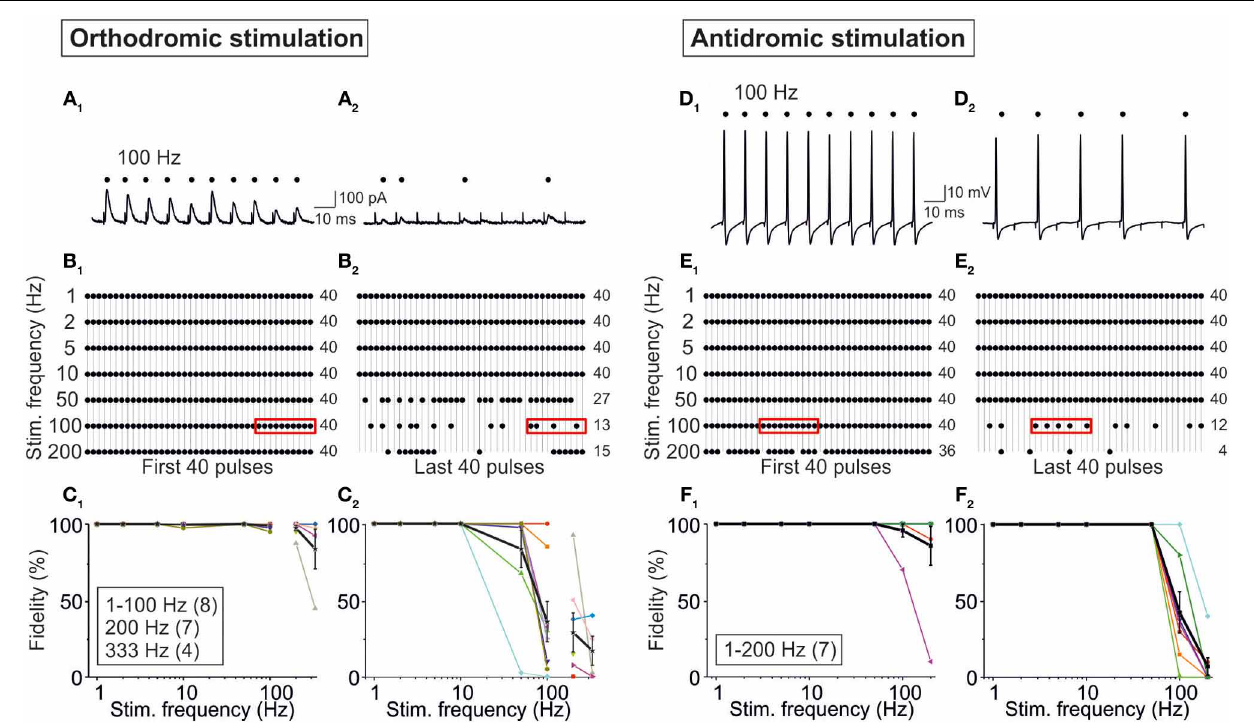
FIGURE 13 | Fidelity analysis of action potentials evoked through orthodromic (A–C) and antidromic (D–F) stimulation of P11/37 ◦ C MNTB axons. Orthodromic stimulation was performed as in Figure 1B 1 , and recordings were obtained from LSO neurons. (A 1 ,A 2 ) Original current traces from a neuron stimulated with 100Hz, depicting IPSCs to stimulus number 31–40 (A 1 ) and to stimulus number 3991–4000 (A 2 ) . Dots mark reliable synaptic transmission; note six failures in (A 2 ) . (B 1 ) Dot plots from the LSO neuron in (A) stimulated with seven frequencies (1–200Hz), illustrating fidelity behavior to stimulus number 1–40. Frame at 100Hz depicts the scenario shown in (A 1 ) . Numbers to the right are the numbers of successful responses. (B 2 ) Dot plots from the same LSO neuron, again stimulated at seven frequencies (1–200Hz), but now illustrating fidelity behavior to stimulus number 3961–4000. Frame at 100Hz depicts the scenario shown in (A 2 ) . Notice the occurrence of failures at frequencies ≥ 50Hz. (C 1 ,C 2 ), Fidelity data of the population of LSO neurons as a function of stimulus frequency. 100% fidelity means 40 successful responses to 40 stimuli (40/40). Individual neurons are depicted in different colors, and mean values ± s.e.m. are shown in